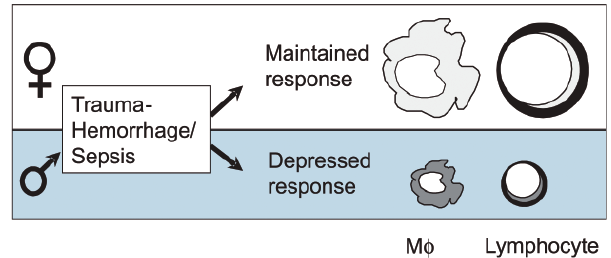
Figure 1 - Schematic illustration of the effect of gender on cell-mediated immune responses following trauma and severe blood